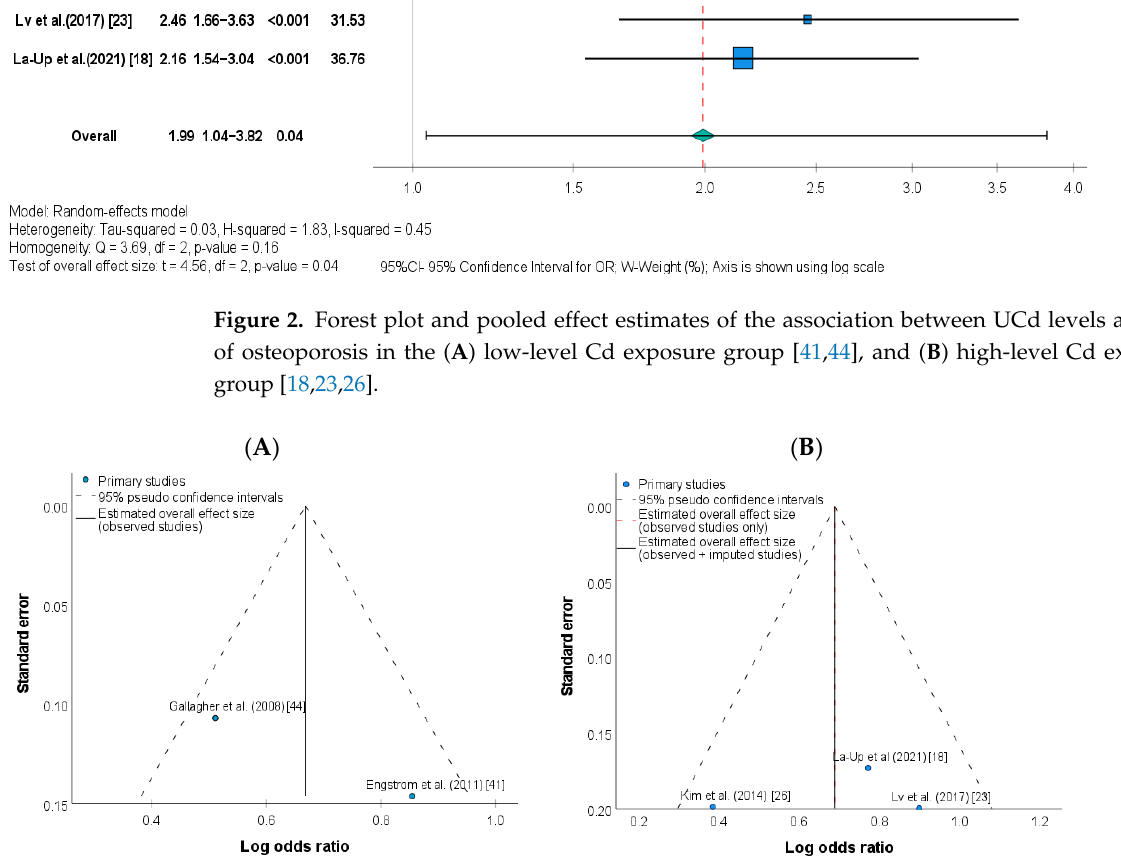
Figure 3. Funnel plot of studies investigating the association between UCd levels and risk of osteo- porosis in the ( A ) low-level Cd exposure group, and ( B ) high-level Cd exposure group. osteoporosis in the ( A ) low-level Cd exposure group [41,44], and ( B ) high-level Cd exposure group